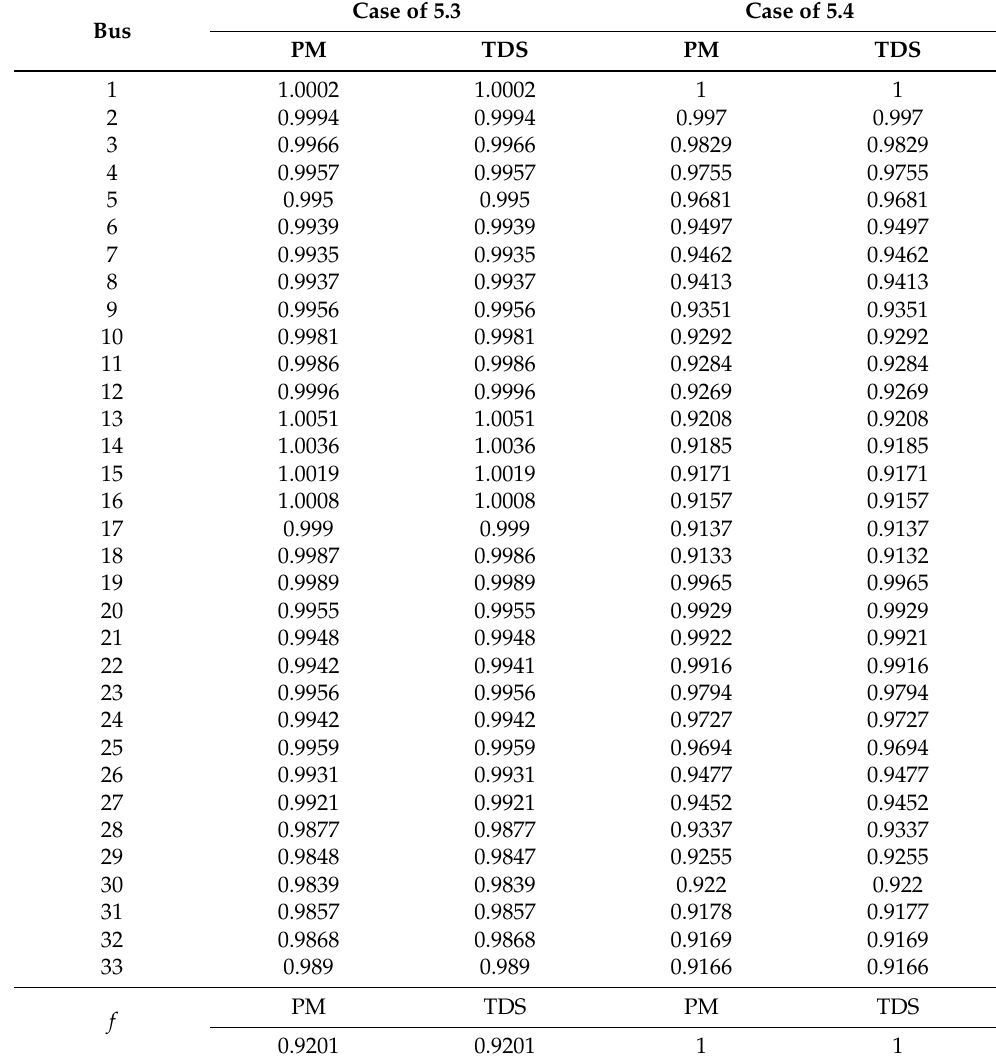
Table 5. Power flow results for 5.3 and